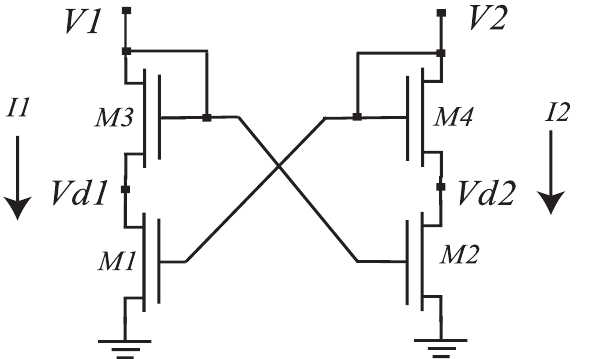
Figure 1. The proposed voltage correlator, where the currents I 1 and I 2 approach their maximum values when voltages V 1 and V 2 become